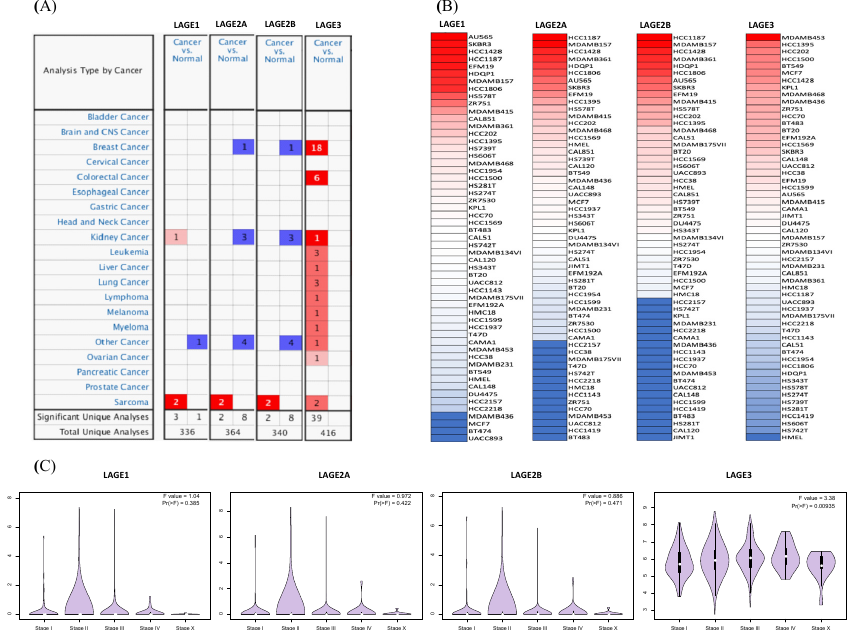
Figure 1. Expressions of L-antigen family genes through cancer tissues. ( A ) LAGE genes expression profiles of 20 types of cancer and normal patients. Decreasing gene rank percentiles are indicated as a color gradient. p value < 0.05, multiple of change of >1.5-fold, and a gene rank percentile of <10% in cancer compared to normal tissues were considered as threshold. ( B ) Heatmap plots collected from the CCLE database show LAGE expression levels in all breast cancer cell lines. Expression levels of LAGEs varied in different breast cancer cell lines. The up blocks with red color illustrate over-expression, and the down blocks showed under-expression. ( C ) Differential expressions of explicit LAGE family members were demonstrated in violin plots derived from the TCGA breast cancer database with a significant p-value set. By using TCGA and METABRIC databases, various stages of tumor across LAGE family gene expression profiles were explored. More elevated gene expression levels of LAGEs were found in higher-stage breast cancers than in lower-stage cancers and normal tissues. Only LAGE3 was clearly shown, whereas the others are still not clear.